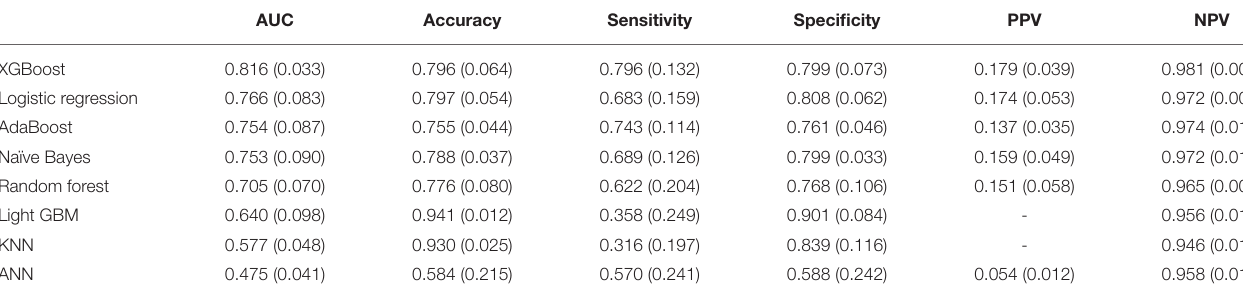
TABLE 3 | The performance of machine learning models for diagnosing referable diabetic retinopathy. AUC